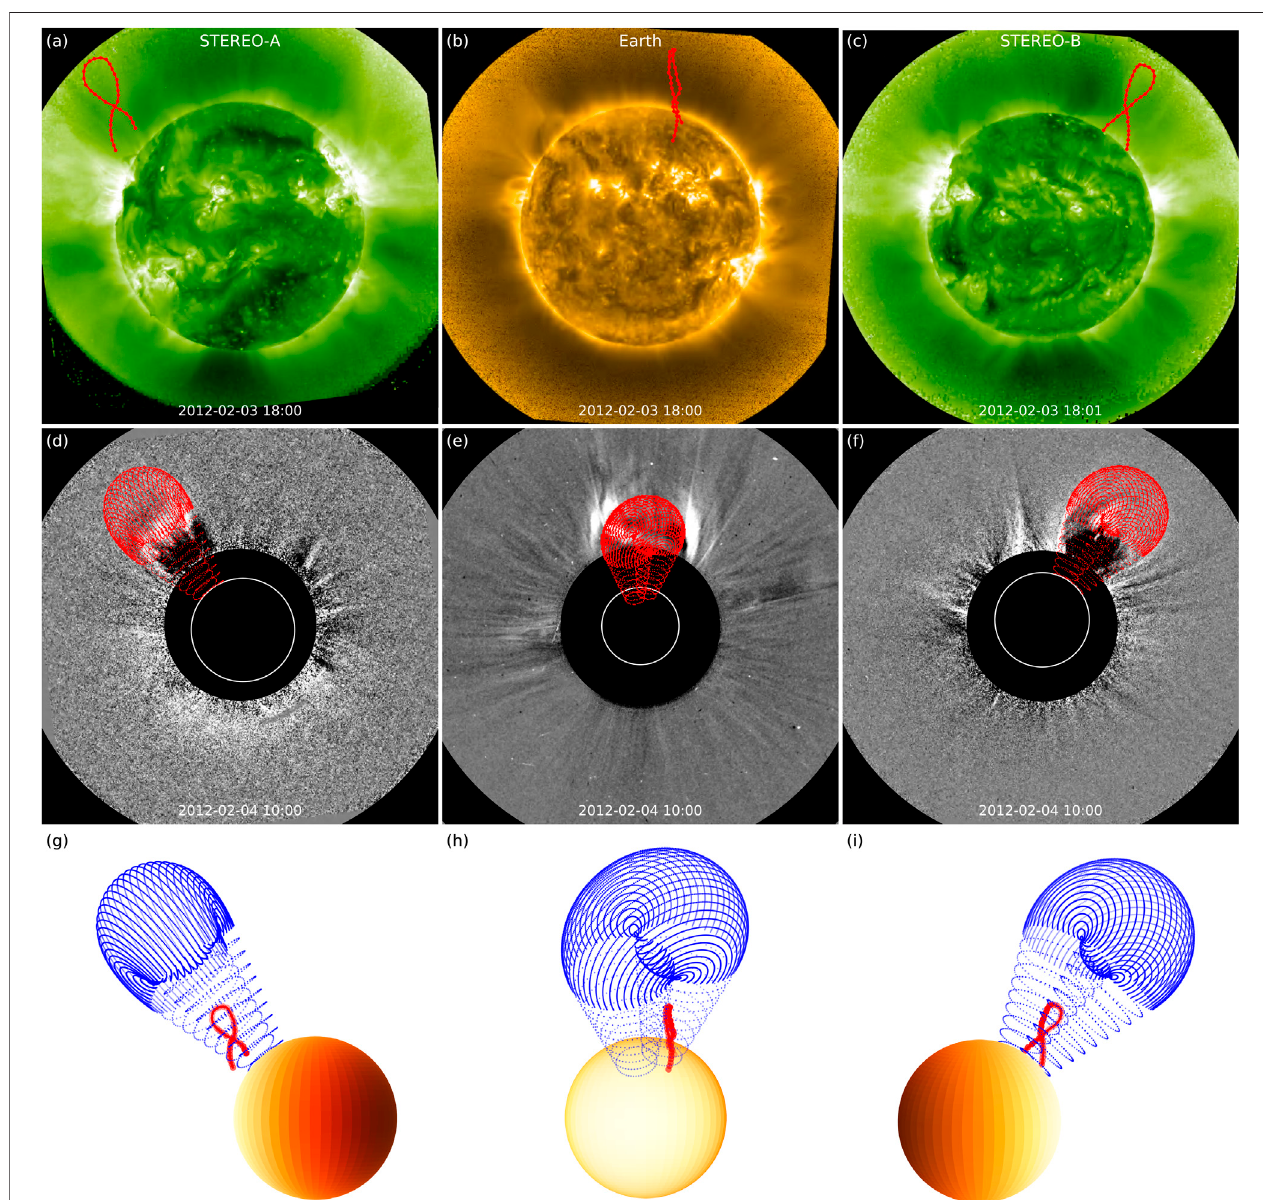
FIGURE 6 | Geometric techniques applied to the 2012 February 4 CME (Event 3). (A – C) Application of the TP technique to the pre-eruptive loop structure. The technique is applied to STEREO-A and STEREO-B images and then projected into the PROBA2 fi eld of view. (D – F) GCS reconstruction applied to the white-light structureseeninSTEREO-A,SOHO,andSTEREO-Bimagery. (G – I) ResultsoftheTPandGCSreconstructiontechniquesdisplayedtogetherina3Drepresentationand shown from the viewpoints of STEREO-A, Earth, and